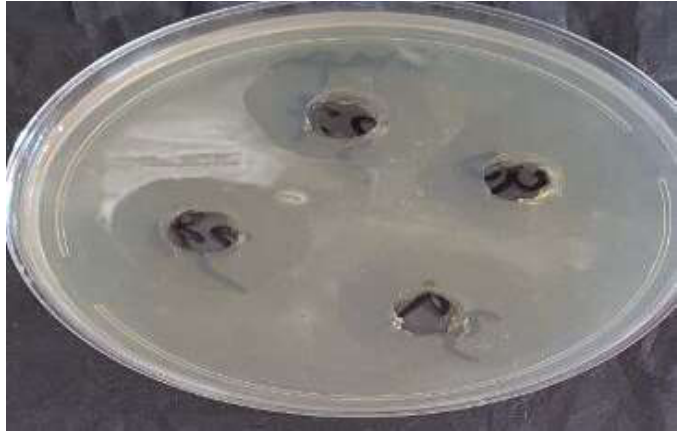
Figure 7: Activity of silver nanoparticles against bacteria. Table 2: Comparison of inhibition diameters of silver nanoparticles on bacteria ( S.aureus, E.coli ).